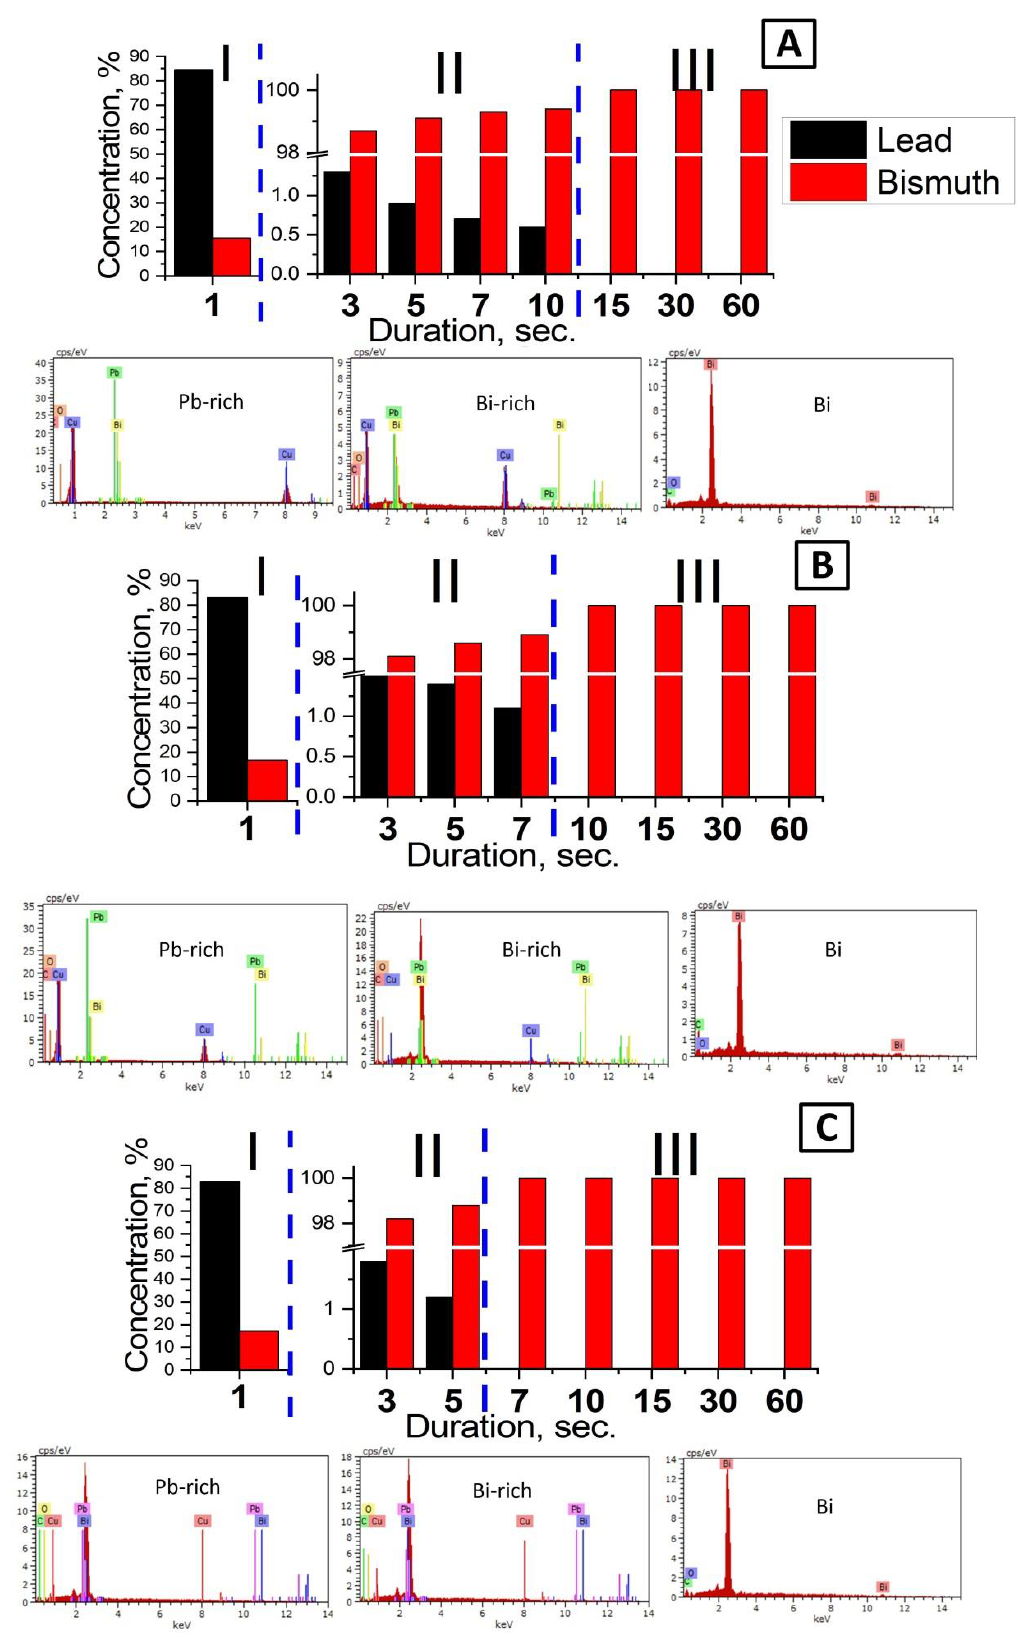
Figure 2. The dependence of the Pb and Bi concentration in electrodeposited films on the deposition duration at current densities of 10 mA/cm 2 ( A ), 15 mA/cm 2 ( B ), and 20 mA/cm 2 ( C ). The insets show the data of energy-dispersive X-ray microanalysis (EDX) analysis.